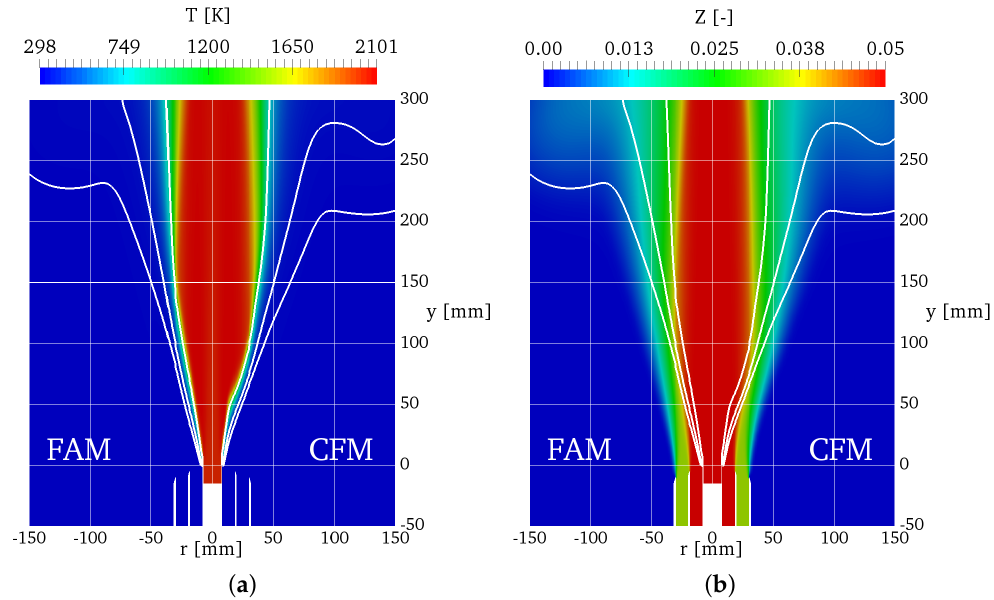
Figure 10. Case A-r: comparison between mean temperature T ( a ); and mean mixture fraction Z ( b ); fields achieved with FAM and CFM models, including iso-lines (solid white) of c = 0.5, c = 0.05 and c = 0.01 (from burner axis towards increasing radii,